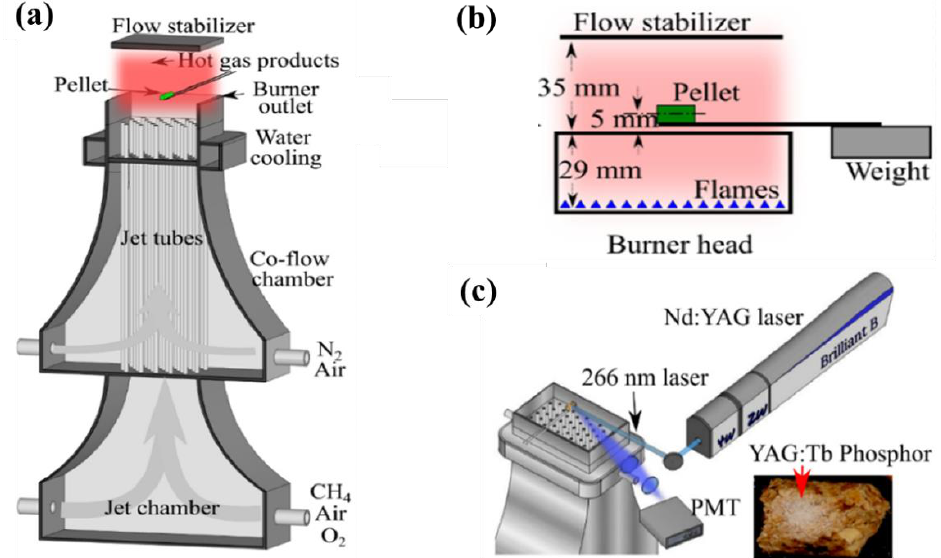
Figure 15. Schematics of ( a ) the multi-jet burner, ( b ) the measured biomass pellet position, and ( c ) experimental setup of phosphor thermometry [127].